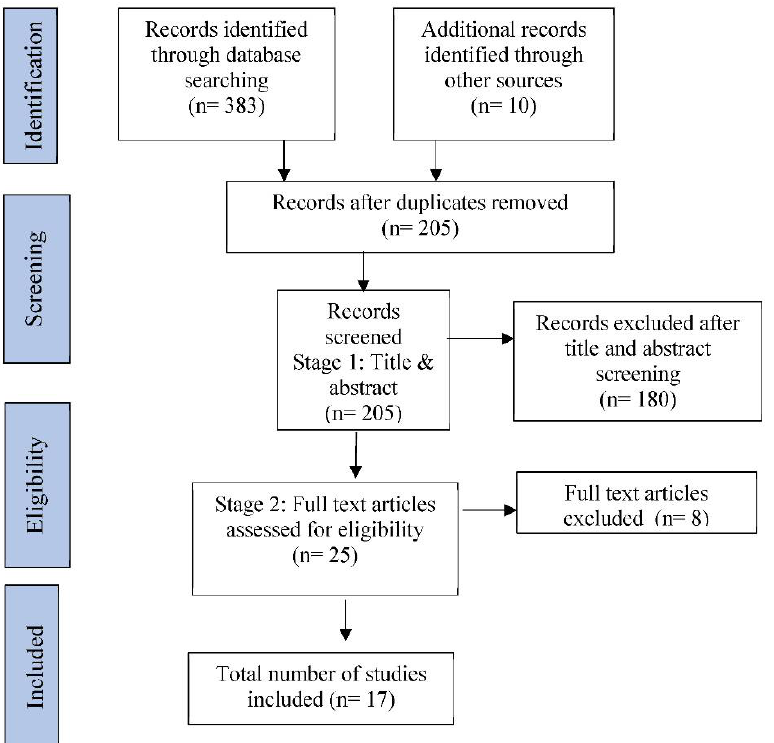
Figure 1. PRISMA diagram.